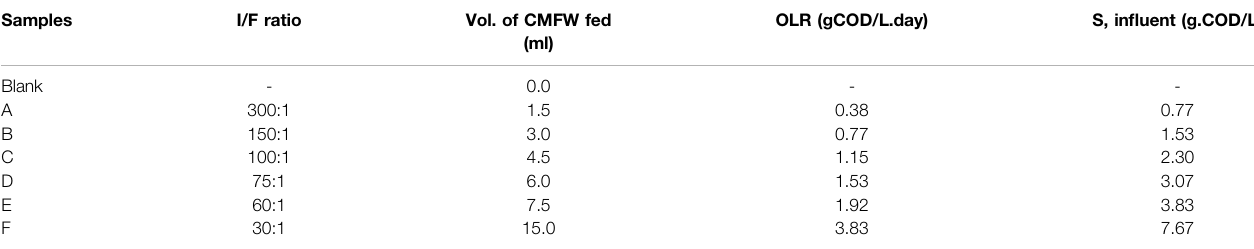
TABLE 1 | Experimental setup for the BMP test. Samples I/F